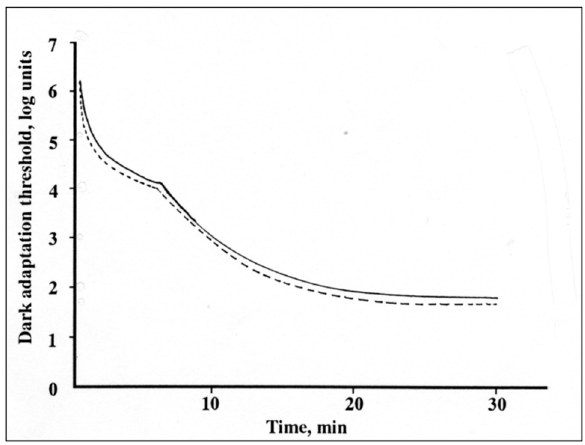
Figure 10. Typical dark adaptation curve before (continuous line) and after (dotted line) BCA intake. Comparison of mean and standard deviations for the bottom of dark adaptation threshold by log unit (log asb) at two hours after BCA intake in the four groups were shown in Table 5. Dark adaptation value in placebo group was 2.018 ± 0.218. The values in AC intake groups were 2.004 ± 0.195 (AC, 12.5 mg/subject), 1.980 ± 0.197 (AC, 25 mg/subject) and 1.923 ± 0.167 (AC, 50 mg/subject), indicating an AC dose dependency (Table 5). At an AC dose of 50 mg/subject, a significant difference ( p = 0.014) was observed in threshold values after intake compared to placebo. Comparison of four AC dose groups before and after intake showed a significant difference ( p = 0.011) for the 50 mg/subject AC dose (Table 5). Table 5. Dark adaptation threshold changes before and after intake of the test drink. Dose of BCA Dark Adaptation Value, Mean ± SD of Log Asb; ( p value) (1) mg/subject Before Intake After Intake Change p value (2)